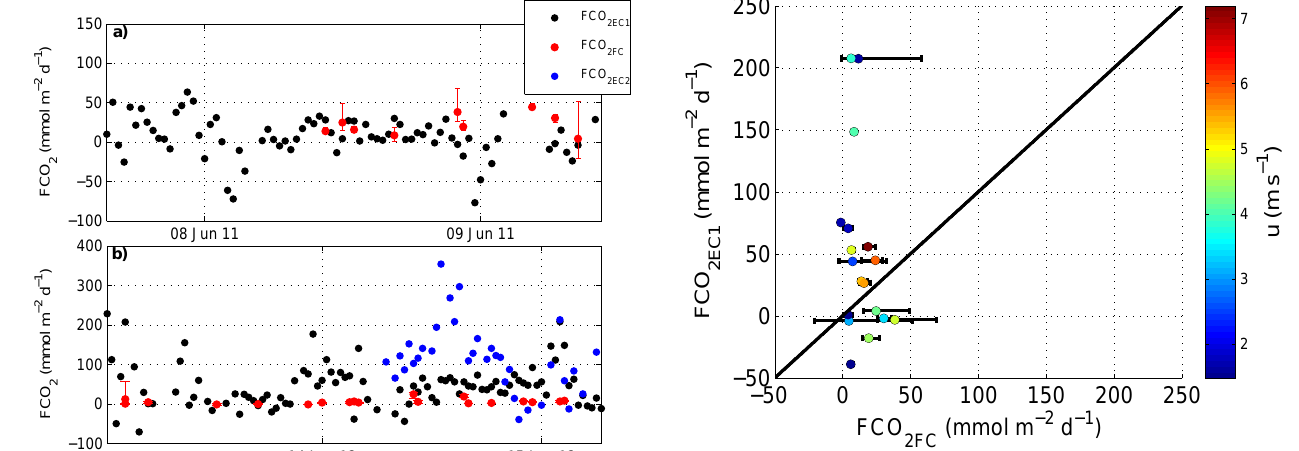
Figure 6. As Fig. 2 but for CO 2 fluxes.